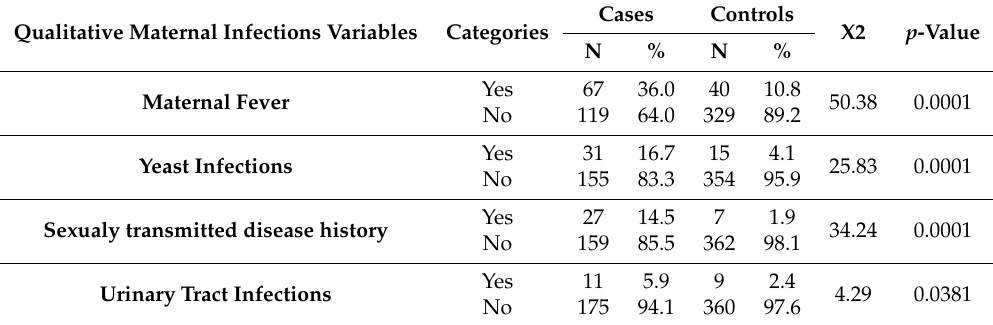
Table 10. Qualitative maternal infections variables in cases (186) and controls